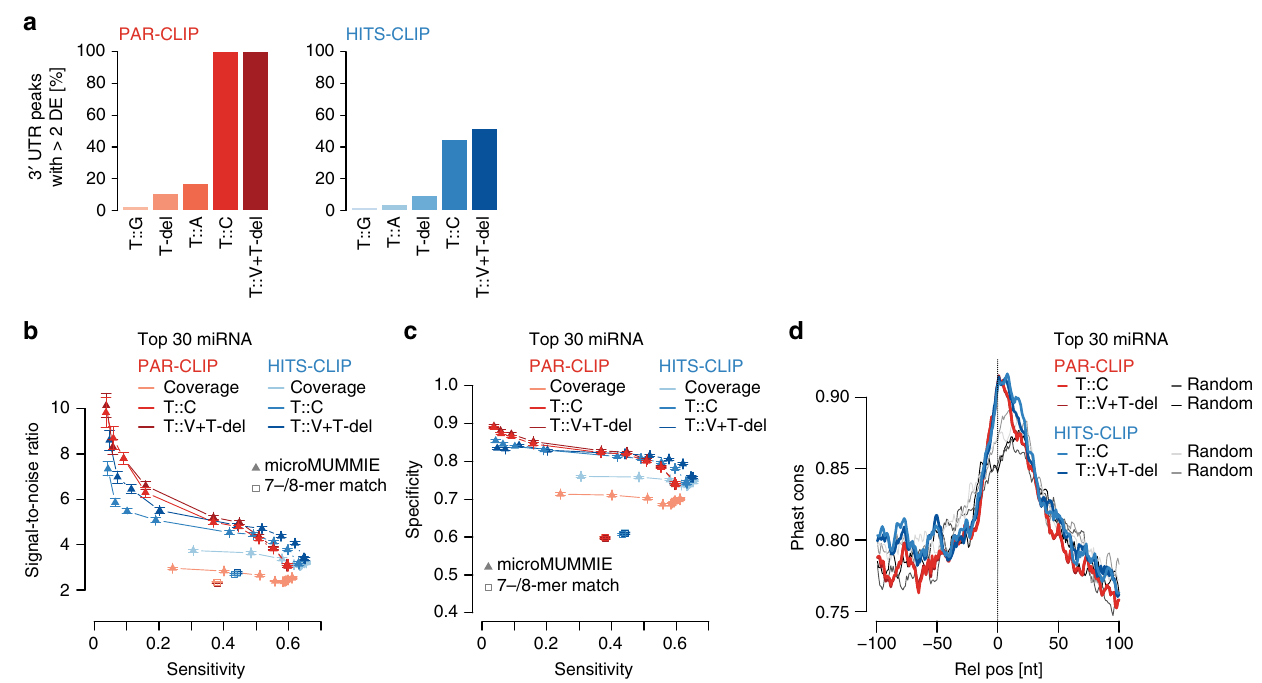
Fig. 3 microMUMMIE assigned miRNA seed matches on PAR-CLIP and HITS-CLIP. a Proportion of IDR-selected peaks forming clusters ( ≥ 2 DEs per 3 ′ UTR peak) depending on individual or combined DEs. b SNR estimate for HITS-CLIP and PAR-CLIP-derived DE signal for miRNA seed match predictions given the top 30 CLIP-enriched miRNAs relative to 30 shuf fl ed decoy miRNAs. In each case, the top 1500 clusters were used. The results are depicted as mean across 100 individual shuf fl ing experiments, with error bars representing SEM. Individual triangles indicate changes in chosen microMUMMIE variance levels. Squares show basic 7mer-A1, 7mer-m8, or 8mer-A1 matches anywhere within clusters. X -axis depicts sensitivity. Coverage = inferred single nucleotide peak summit position. c Similar to ( b ), but depicting speci fi city vs. sensitivity. d UCSC 27way PhastCons scores relative to the inferred crosslinked nucleotides for Clusters with miRNA seed match (at microMUMMIE variance 0.01; viterbi mode) prediction or a random nucleotide within